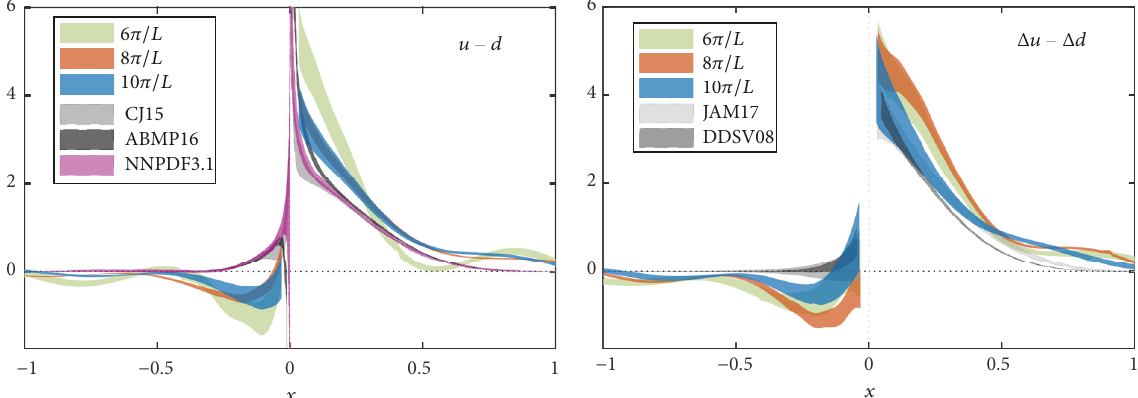
Figure 21: Comparison of ETMC’s unpolarized (left) and helicity (right) PDF for momenta 0.83 GeV (green band), 1.11 GeV (orange band), and 1.38 GeV (blue band). The results from the phenomenological analysis of ABMP16 [213] (NNLO), NNPDF [211] (NNLO), CJ15 [214] (NLO), DSSV08 [206], NNPDF1.1pol [207], and JAM17 NLO phenomenological data [215] are displayed for illustrative purposes. Source: [124], reprinted with permission by the Authors (article published under the terms of the Creative Commons Attribution 4.0 International